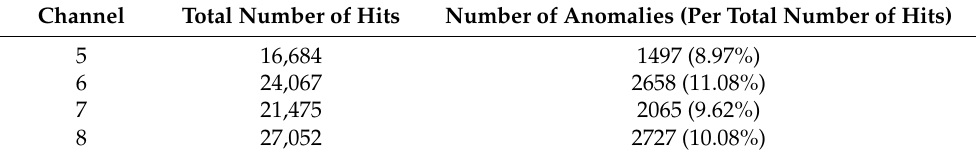
Table 2. Hit removal result.